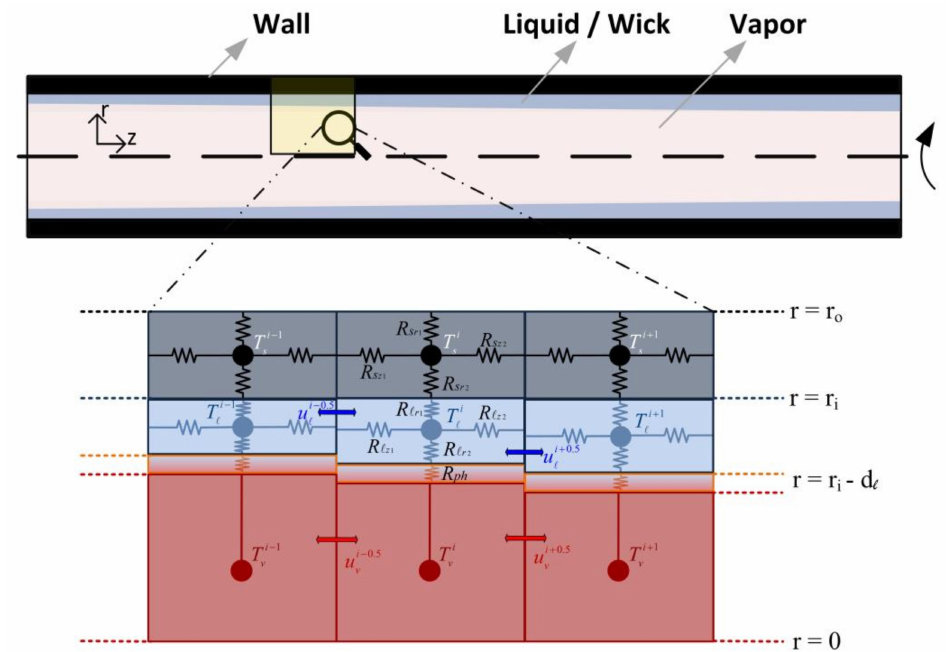
Figure 1. Model geometry and